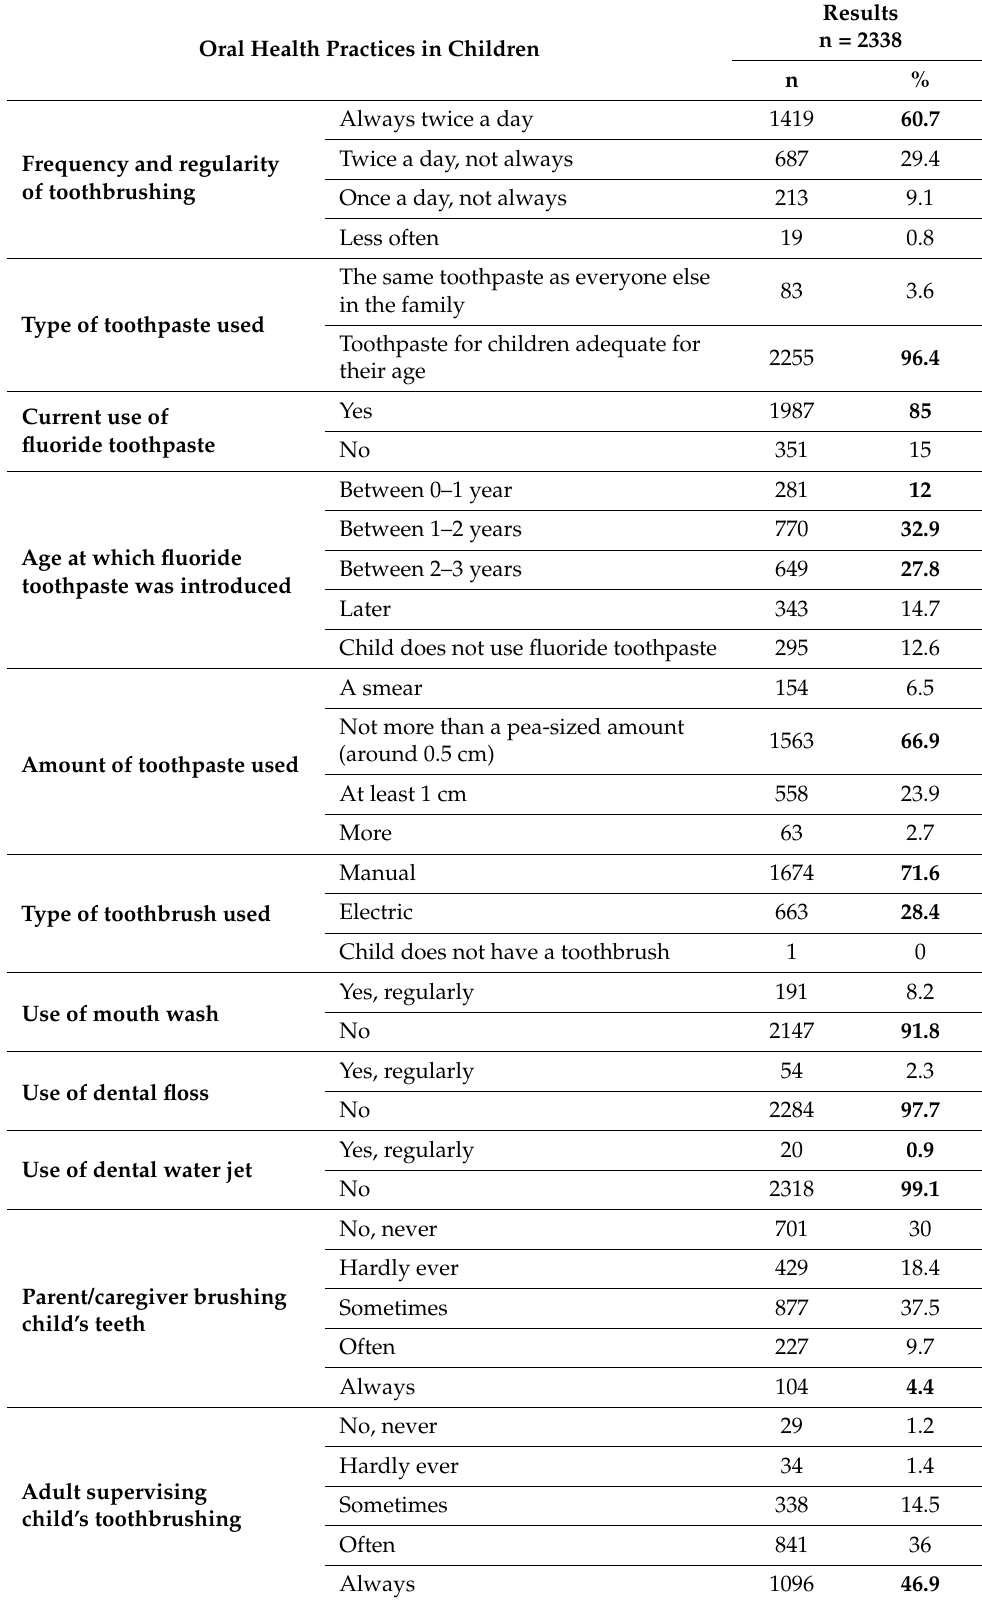
Table 2. Oral health practices in children according to